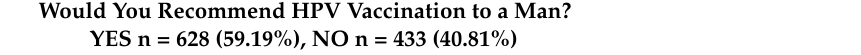
Table 5. Factors influencing medical students’ intention to recommend HPV vaccination men (univariate and multivari- ate